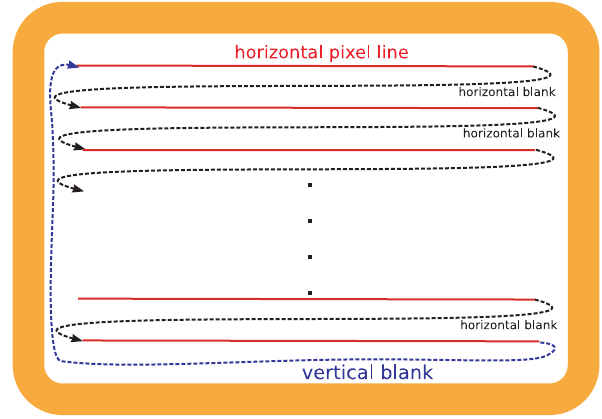
Figure 1. Schematic of the CRT raster scan. The dashed arrows depict the course of the electron beam. The duration of the vertical blank is about 5% of the frame.